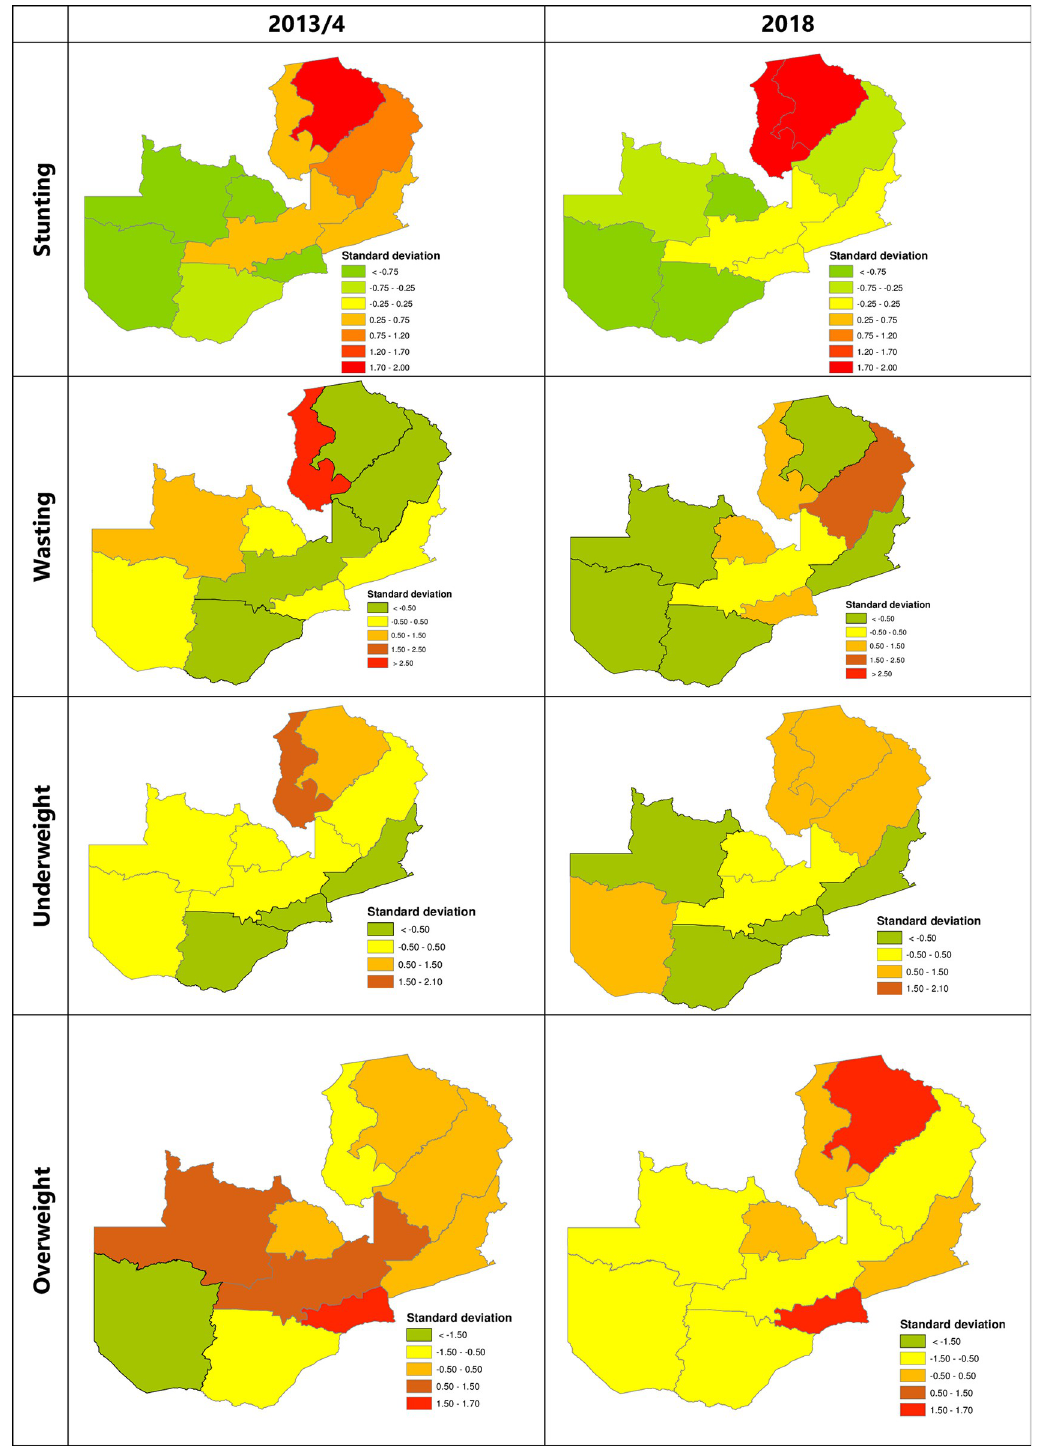
Fig 2. Spatial variation of stunting prevalence, wasting prevalence, and underweight prevalence by provinces in Zambia. Generated with ArcMap 10.7 by ESRI (https://desktop.arcgis.com/en /). (Source: author generated map).